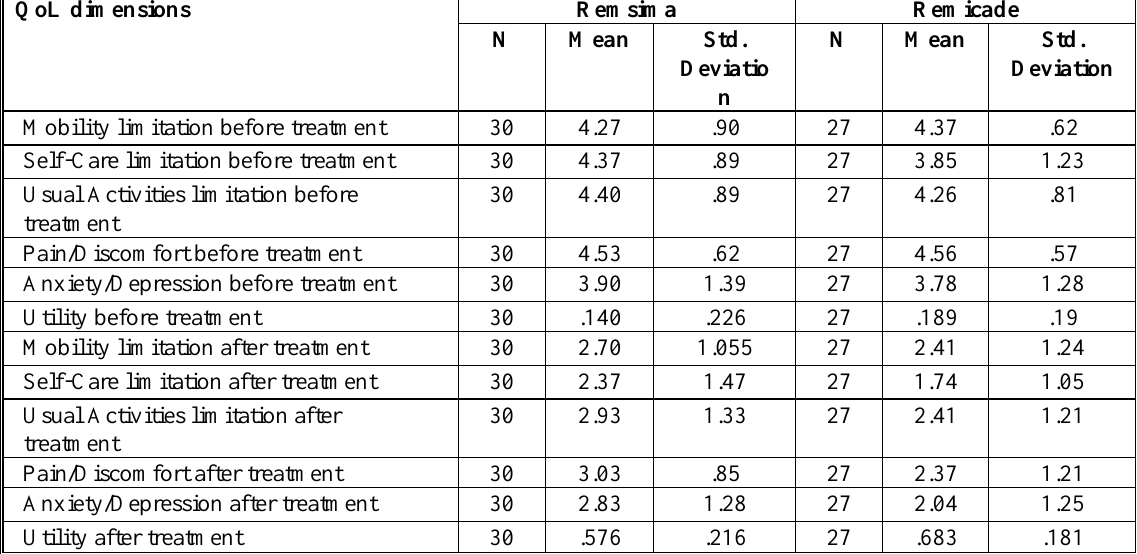
Table 7. The measures of utility and QoL dimensions of the RA patients before and after Remsima or Remicade